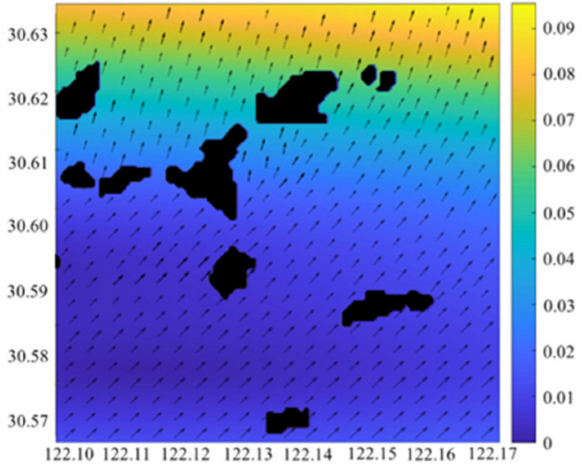
Figure 5. Current field map of local